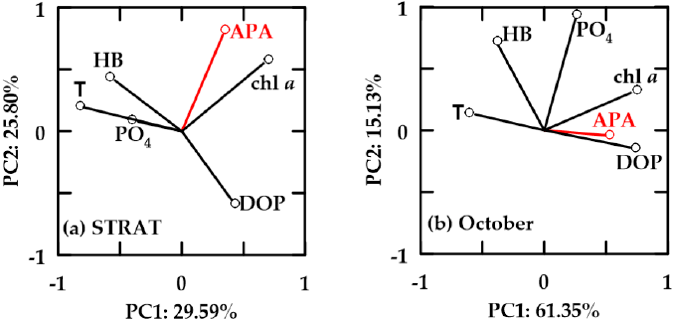
Figure 9. Principal component analysis (PCA) for relevant variables in oxygen-saturated aged-FW waters during (a) STRAT and (b) October. Abbreviations are reported in Figure 8.